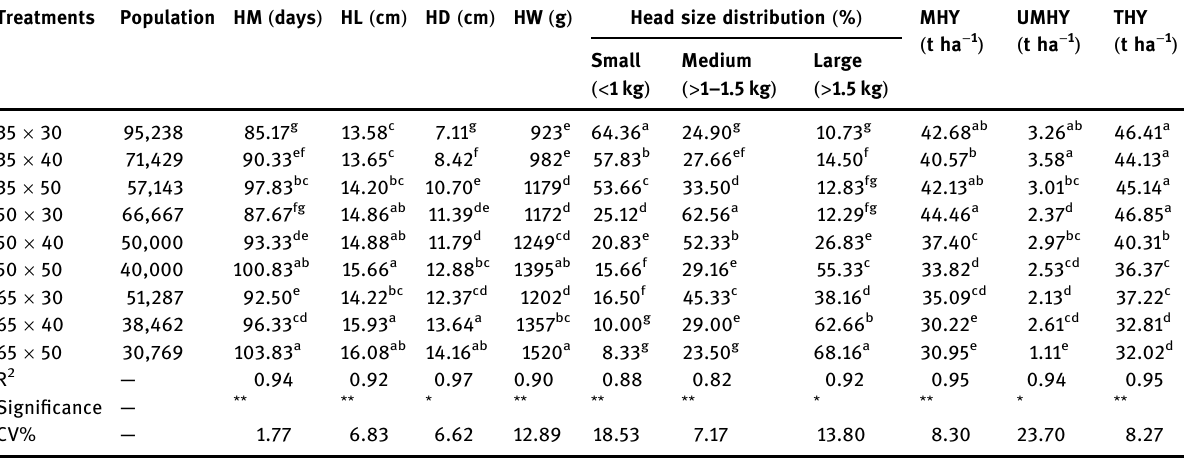
Table 3: Interaction e ff ect of inter - and intra - row spacing on maturity and yield component of cabbage Treatments Population HM ( days ) HL ( cm ) HD ( cm ) HW ( g